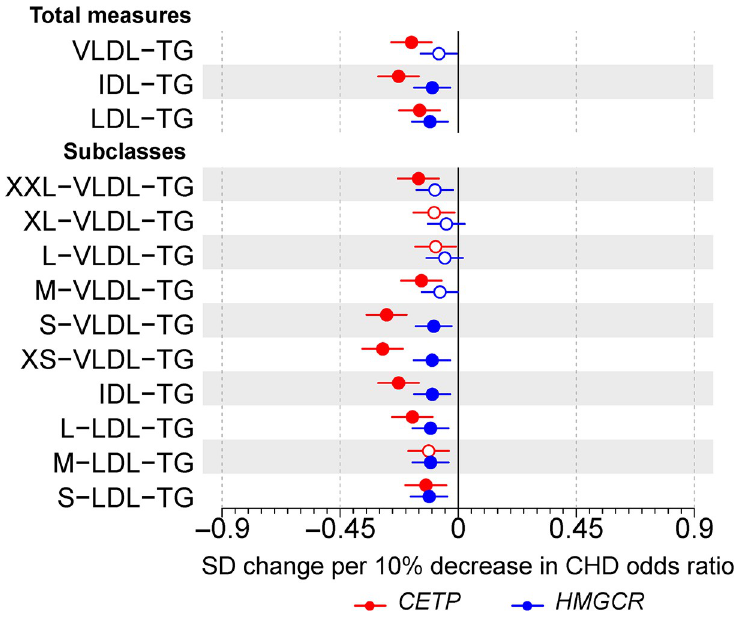
Fig 2. Associations of genetic variants in CETP rs247617 (red) and HMGCR rs12916 (blue) with circulating triglyceride concentrations in size-specific apolipoprotein B particles. Estimates represent the standardized difference in lipoprotein trait, with per allele associations scaled to a 10% lower relative risk of CHD. Analyses were adjusted for age, sex, genotyping batch, and 10 genetic principal components. The circles refer to the effect estimates and the horizontal bars to the 95% CIs. Closed circles represent statistical significance of associations at P < 0.002 and open circles associations that are nonsignificant at this threshold. The lipoprotein subclasses are defined by particle size [17–19]: potential chylomicrons and the largest VLDL particles (XXL-VLDL; average particle diameter � 75 nm); 5 different VLDL subclasses, i.e., very large (average particle diameter 64.0 nm), large (53.6 nm), medium (44.5 nm), small (36.8 nm), and very small VLDL (31.3 nm); IDL (28.6 nm); and 3 LDL subclasses, i.e., large (25.5 nm), medium (23.0 nm), and small LDL (18.7 nm). Underlying data can be found in S1 Data. CHD, coronary heart disease; IDL, intermediate-density lipoprotein; LDL, low-density lipoprotein; TG, triglyceride; VLDL, very-low-density